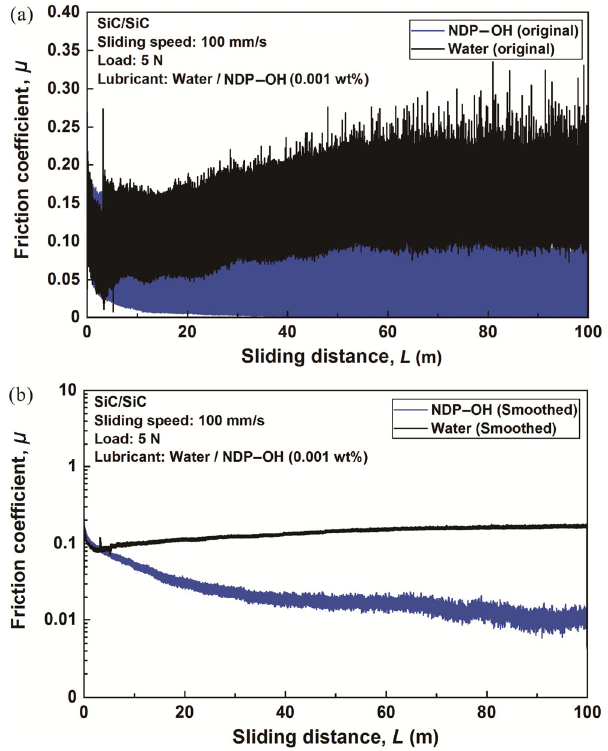
Fig. 4 Friction properties of SiC/SiC with sliding in NDP– OH (0.001 wt%) and pure water: (a) Original evolution of friction coefficient and (b) smoothed log-scale evolution curve using moving average method. L is the sliding distance, m.